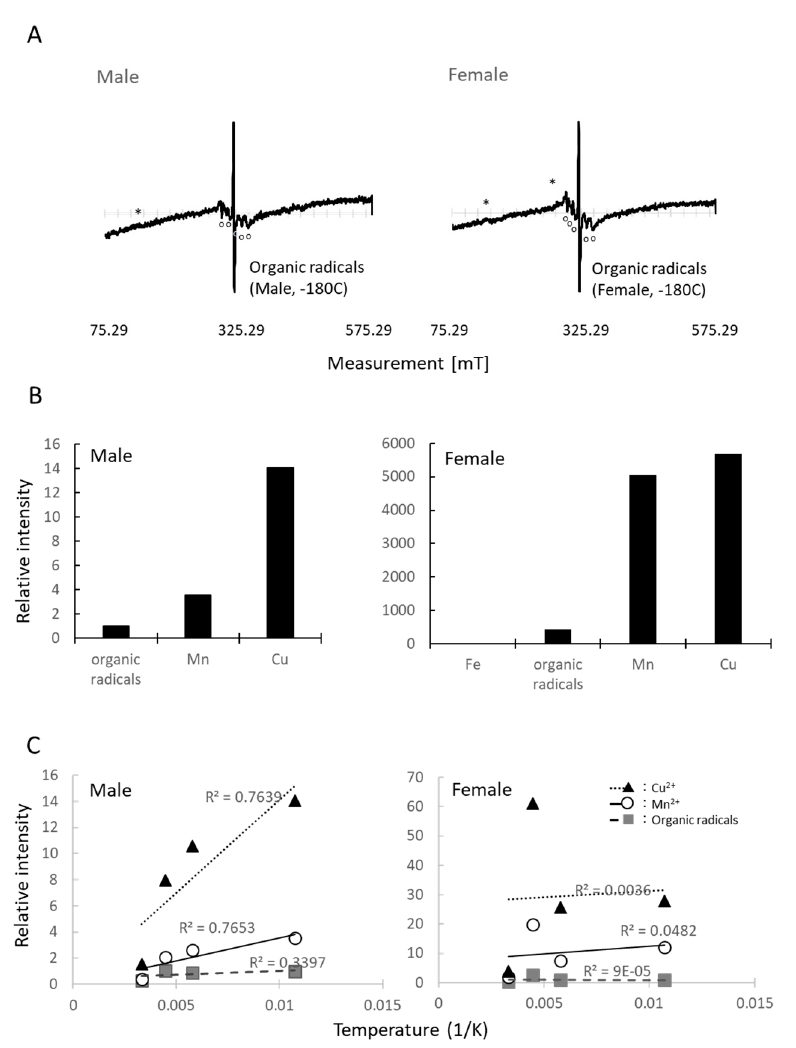
Figure 4. ESR spectra of the fruit flies, D. melanogaster . ( A ) ESR spectrum of the fruit flies at − 180 °C (male 43.2 mg, female 80.3 mg); ( B ) Relative intensity of paramagnetic substances when organic radicals were set as standard (=1) in males with the intensity at − 100 °C, and Fe 3+ (=1) in females at − 180 °C to compare with other paramagnetic substance es. Spin intensity of Fe 3+ in males was too small to measure; ( C ) Interactions with microwaves suggested by temperature-dependent ESR spectrum. If the relative intensity increased proportionally, it suggests that there was no interaction with microwaves. The intensity at − 180 °C was set as standard (=1) for each paramagnetic substance to compare the intensity with other temperatures. K: temperature in Kelvin. * indicates the spectrum of iron (Fe 3+ ). ○ indicates the spectrum of manganese (Mn 2+ ). The S-shaped curve over the Mn spectra indicates the presence of copper (Cu 2+ ). The g value shows the dimensionless quantity that characterizes the magnetic moment and angular momentum of a composite particle, particle, or nucleus.